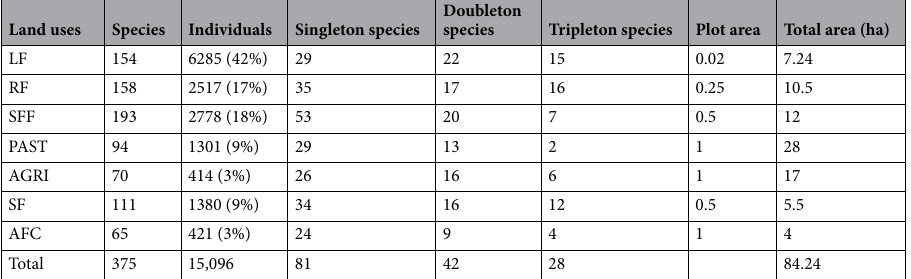
Table 1. Number of species found by land use in Catacamas. The different land uses are secondary forest (SF), secondary forest fragment (SFF), agroforestry coffee (AFC), agriculture (AGRI) and pastures (PAST), live fences (LF) and riparian forest (RF).